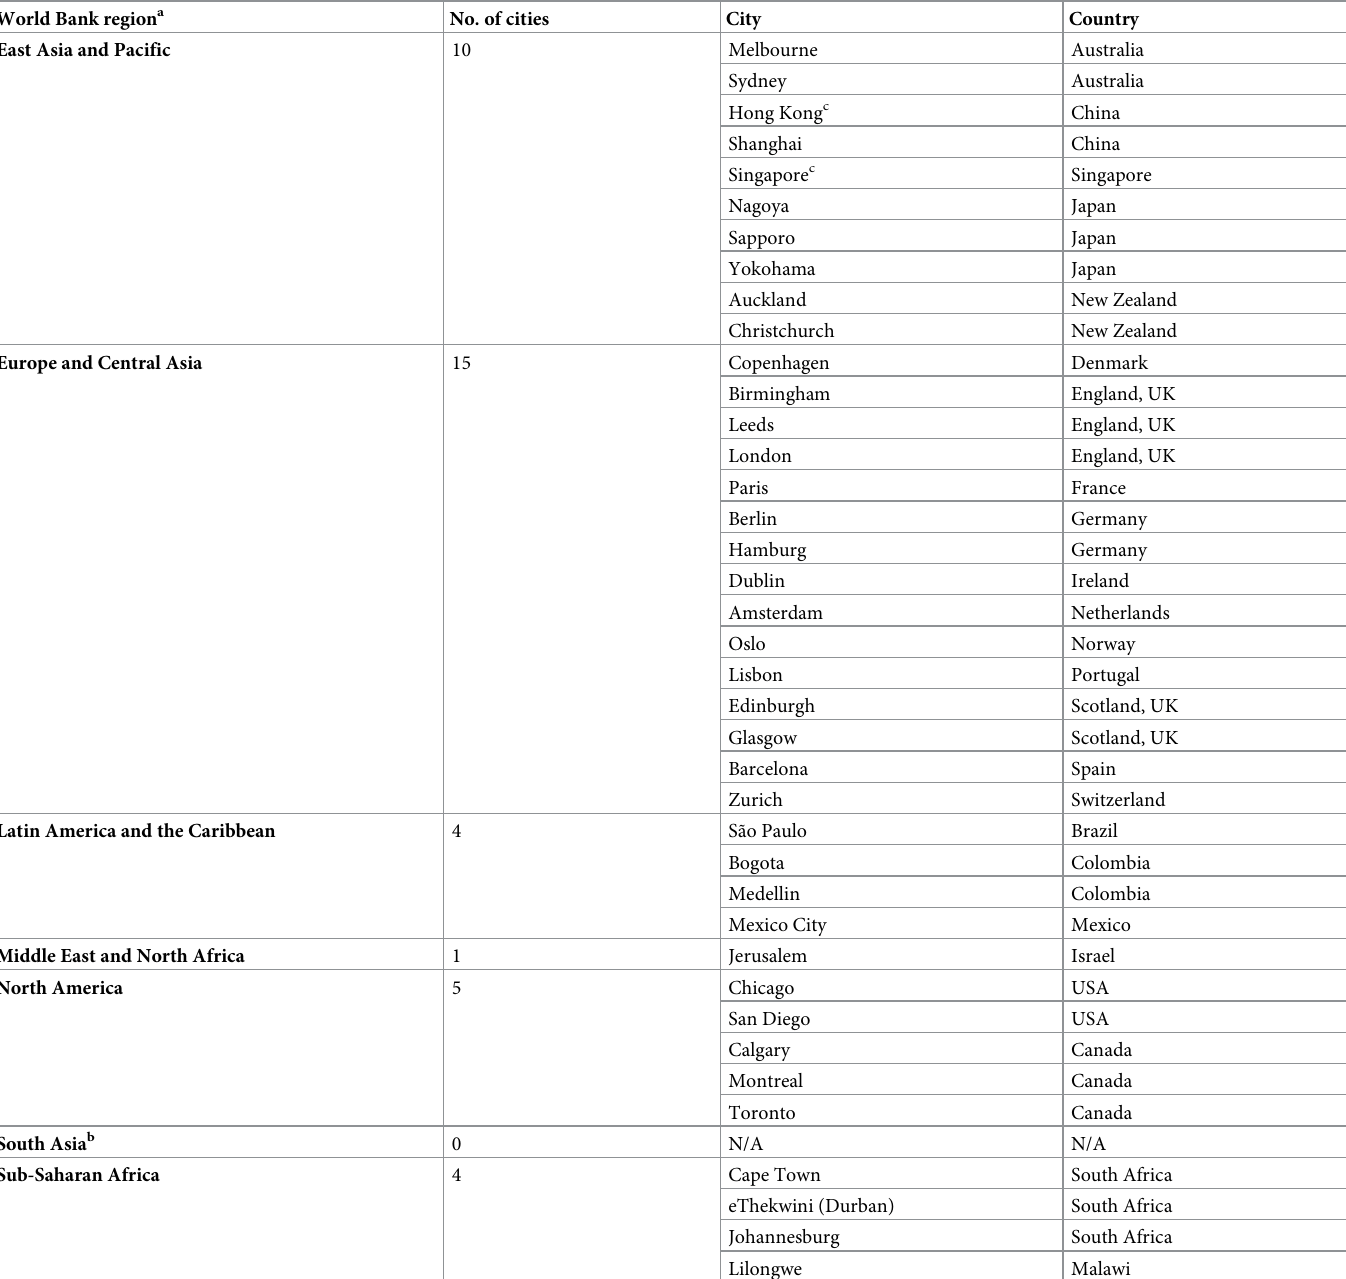
Table 1. Regional distribution of the 39 cities included in this